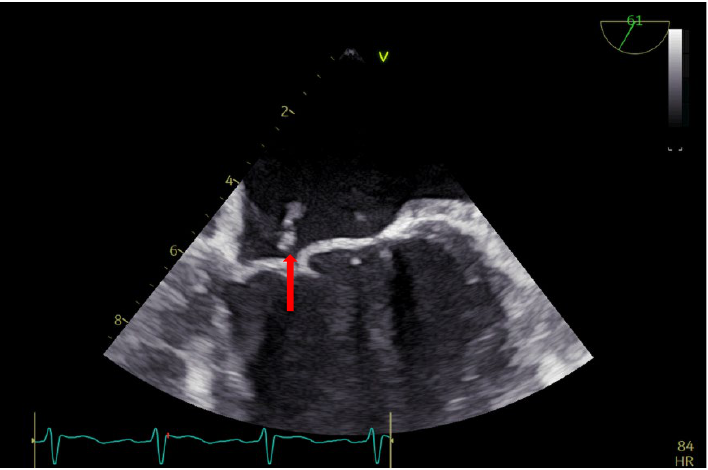
Figure 2. TEE: vegetation on the anterior mitral valve in the cleft area (arrow) .